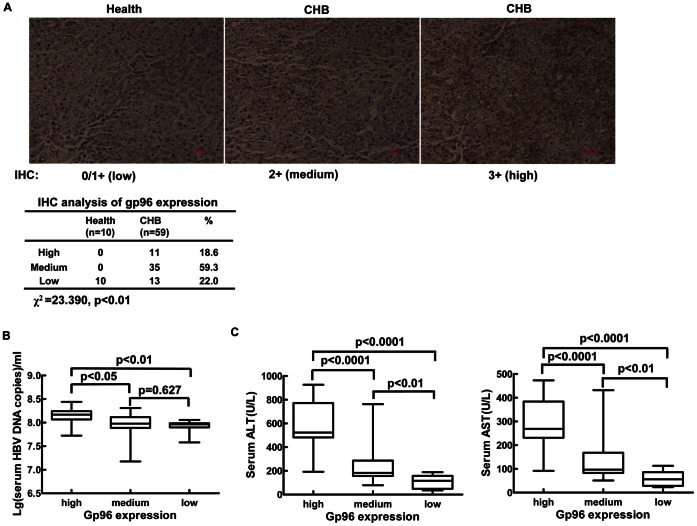
Gp96 expression in the liver is correlated with viral loads and serum ALT/AST levels in CHB patients.(A) IHC detection of gp96 expression in healthy and CHB liver tissues. Representative images indicating immunostaining intensities of 0/1+, 2+, and 3+ are shown. Statistical analysis of gp96 expression by Pearson’s χ test is presented in the lower panel. (B) Distribution of serum HBV DNA loads in CHB patients with low, medium, and high gp96 expression in the liver. (C) Distribution of serum ALT and AST levels in CHB patients with low, medium, and high gp96 expression. Student’s t test was used to determine P-values.